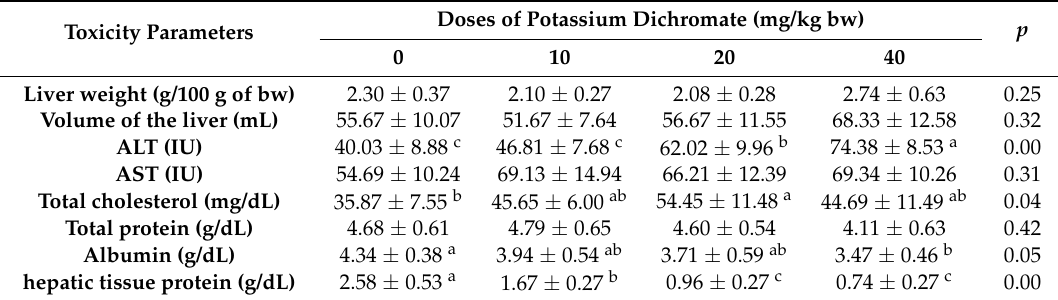
Table 3. Effects of potassium dichromate on liver weight and volume and biochemical markers of hepatotoxicity in rabbit does.